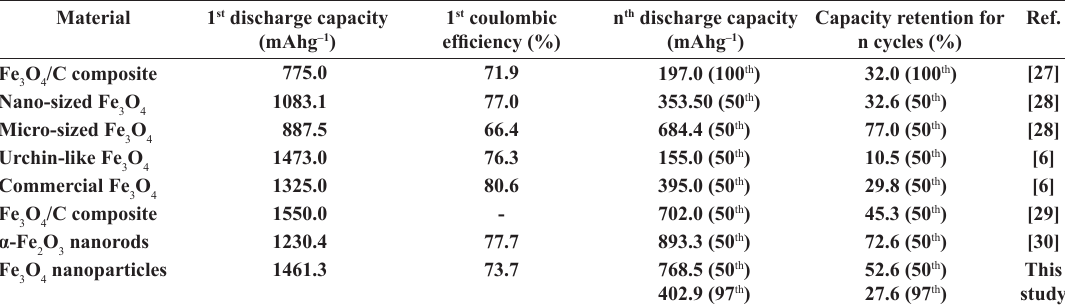
Figure 4. Discharge/charge cycling performance at different current densities of Fe O nanoparticles. 3 4 Table 1. Comparison of published literature data with that obtained in this work.